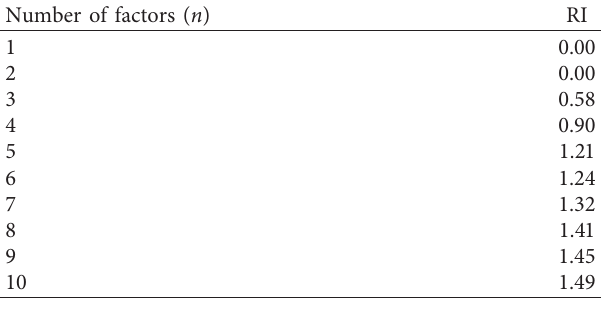
Table 7: RI values according to the number of factors n